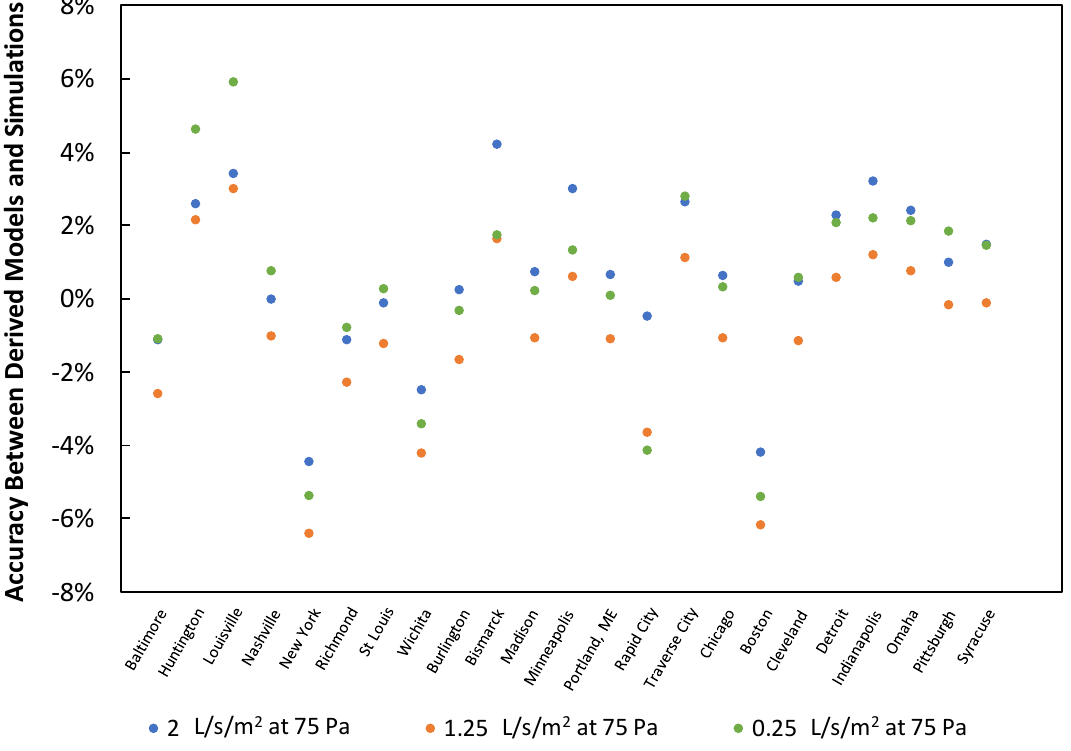
annual savings. Figure 7. Results from models that calculate the annual relative heating energy savings with increased airtightness in stand-alone retail prototype buildings in climate zones 4A, 5A, 5B, and 6B using Equation (1) and constant values in Table 3.